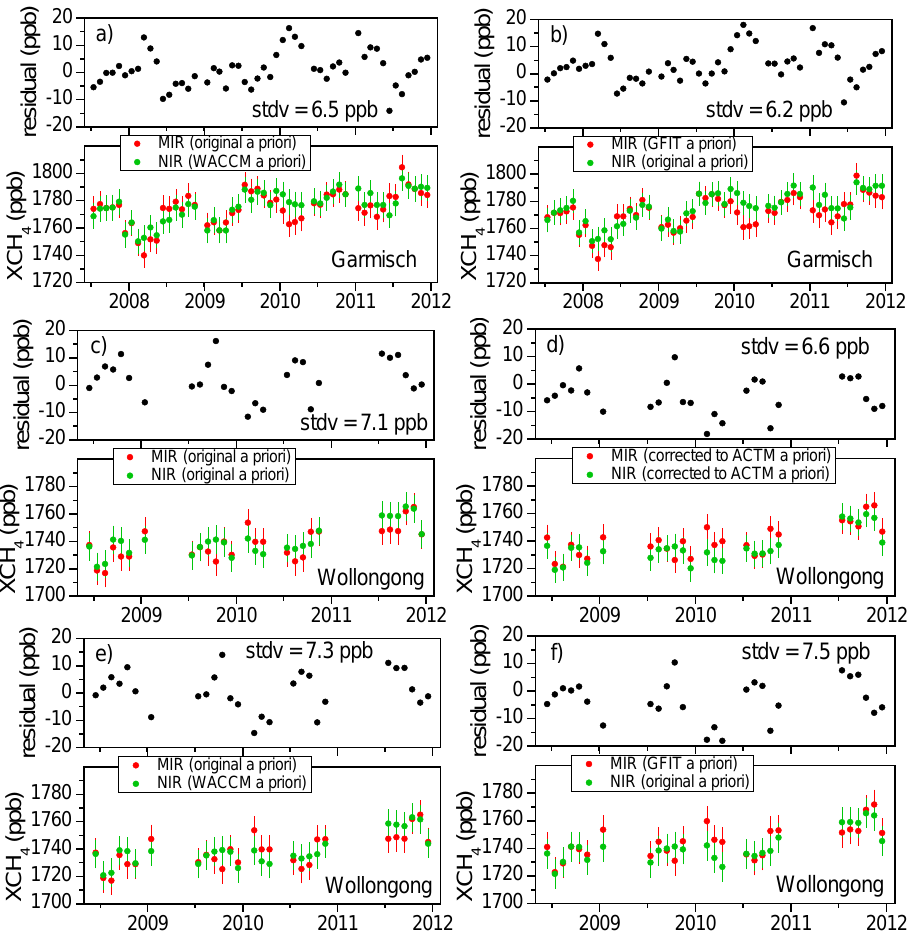
Fig. C2. Same as Fig. 5 but using (a) for Garmisch the WACCM a priori profile as common prior (i.e. the standard prior of the Garmisch MIR retrievals), (b) for Garmisch the GFIT a priori profile (i.e. the standard prior of the NIR retrievals), (c) for Wollongong the original a prioris, (d) for Wollongong a correction to 3-hourly ACTM profiles as common prior, (e) for Wollongong the WACCM a priori profile, and (f) for Wollongong the GFIT a priori profile.